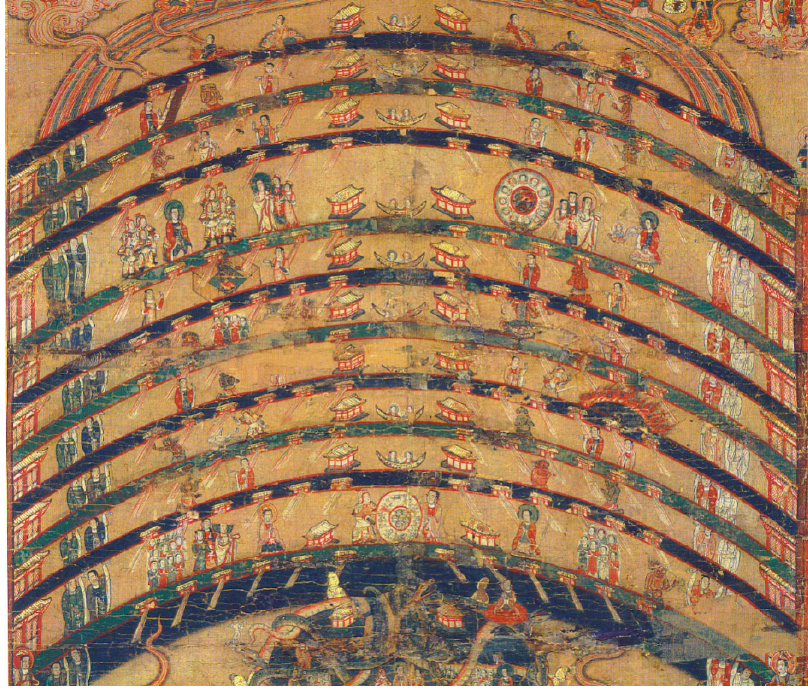
Figure 8. Ten Firmaments of the Sky (Yoshida and Furukawa 2015, Plate 6).